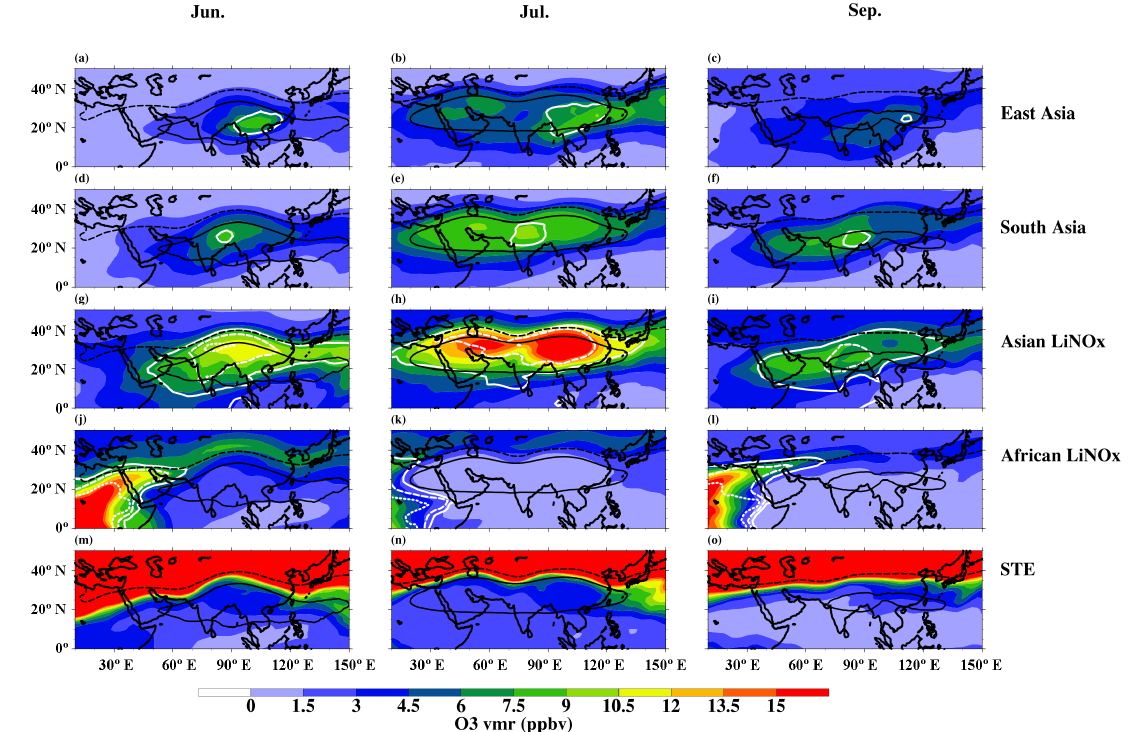
Figure 14. Same as in Fig. 13 for the distributions at